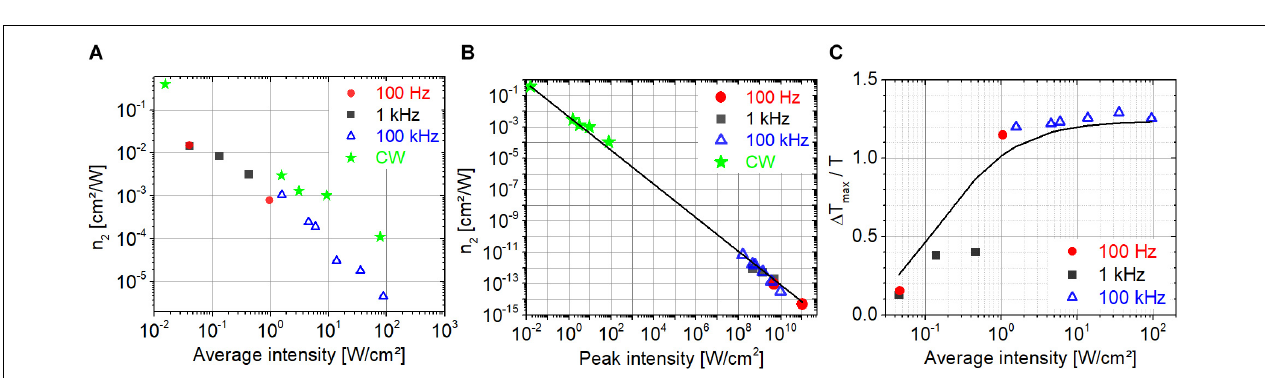
FIGURE 7 | (A) Open-aperture Z-scan traces measured on bR using fs laser pulses at 514 nm at three excitation intensities at a repetition rate of 1 kHz. (B) Saturation intensities extracted from the open-aperture traces in panel (A) . (C) Closed-aperture Z-scan traces obtained at 514 nm excitation corresponding to the curves in panel (A) . The symbols are the measured data points, and lines show the fitted traces.